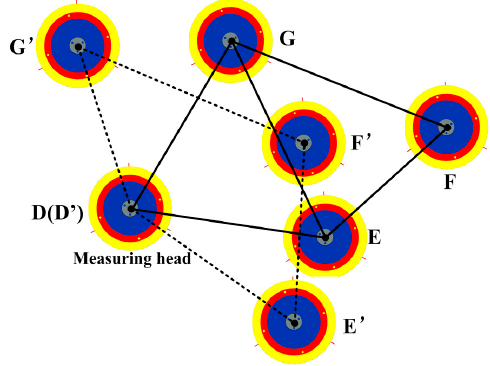
Figure 5. The measurement model of double triangles.